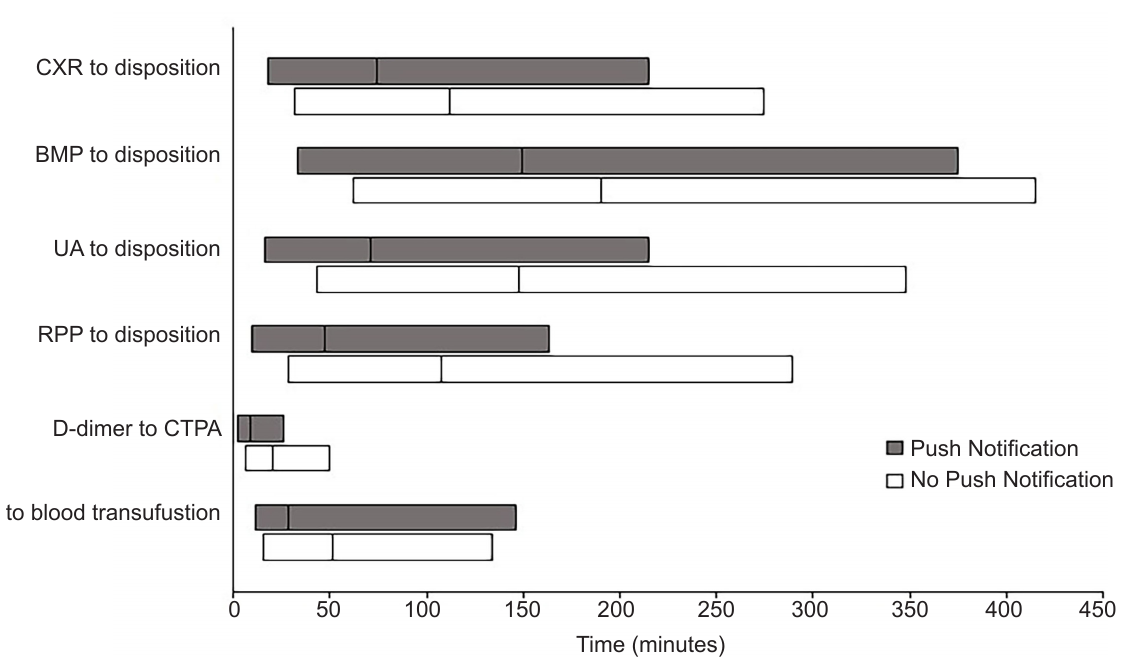
Figure 1. Boxplot of median minutes and interquartile ranges for time to disposition or time to follow-up order in each clinical scenario studied. CXR , chest radiograph; BMP , basic metabolic panel; UA , urinalysis; RPP , respiratory pathogen; CTPA , computed tomography pulmonary angiography; Hb ,